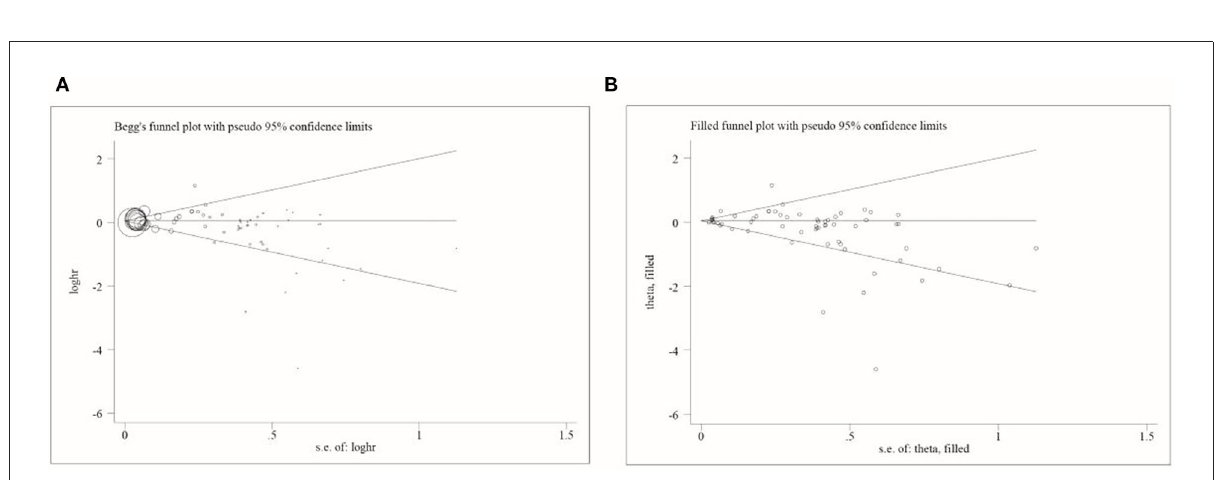
FIGURE3 Begg’s and filled funnel plots in included studies. (A) Begg’s funnel plot and (B) filled funnel